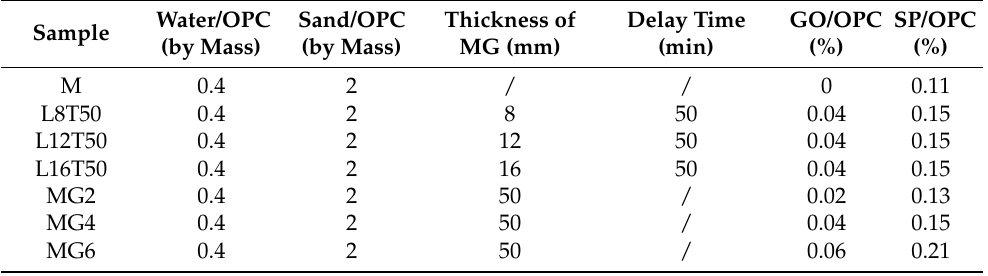
Table 3. Dry mix compositions of layered and nonlayered cement mortars for RCM